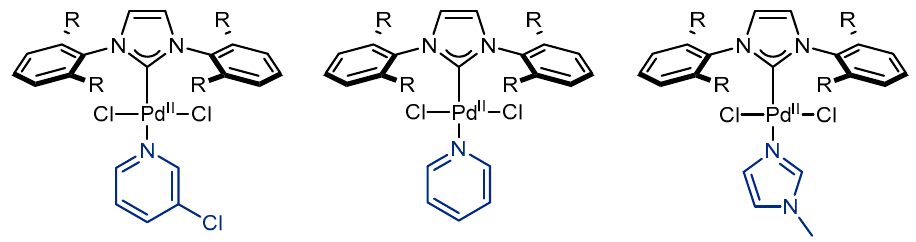
Figure 3. Well-defined Pd-PEPPSI pre-catalysts employed in the cross-coupling reactions.